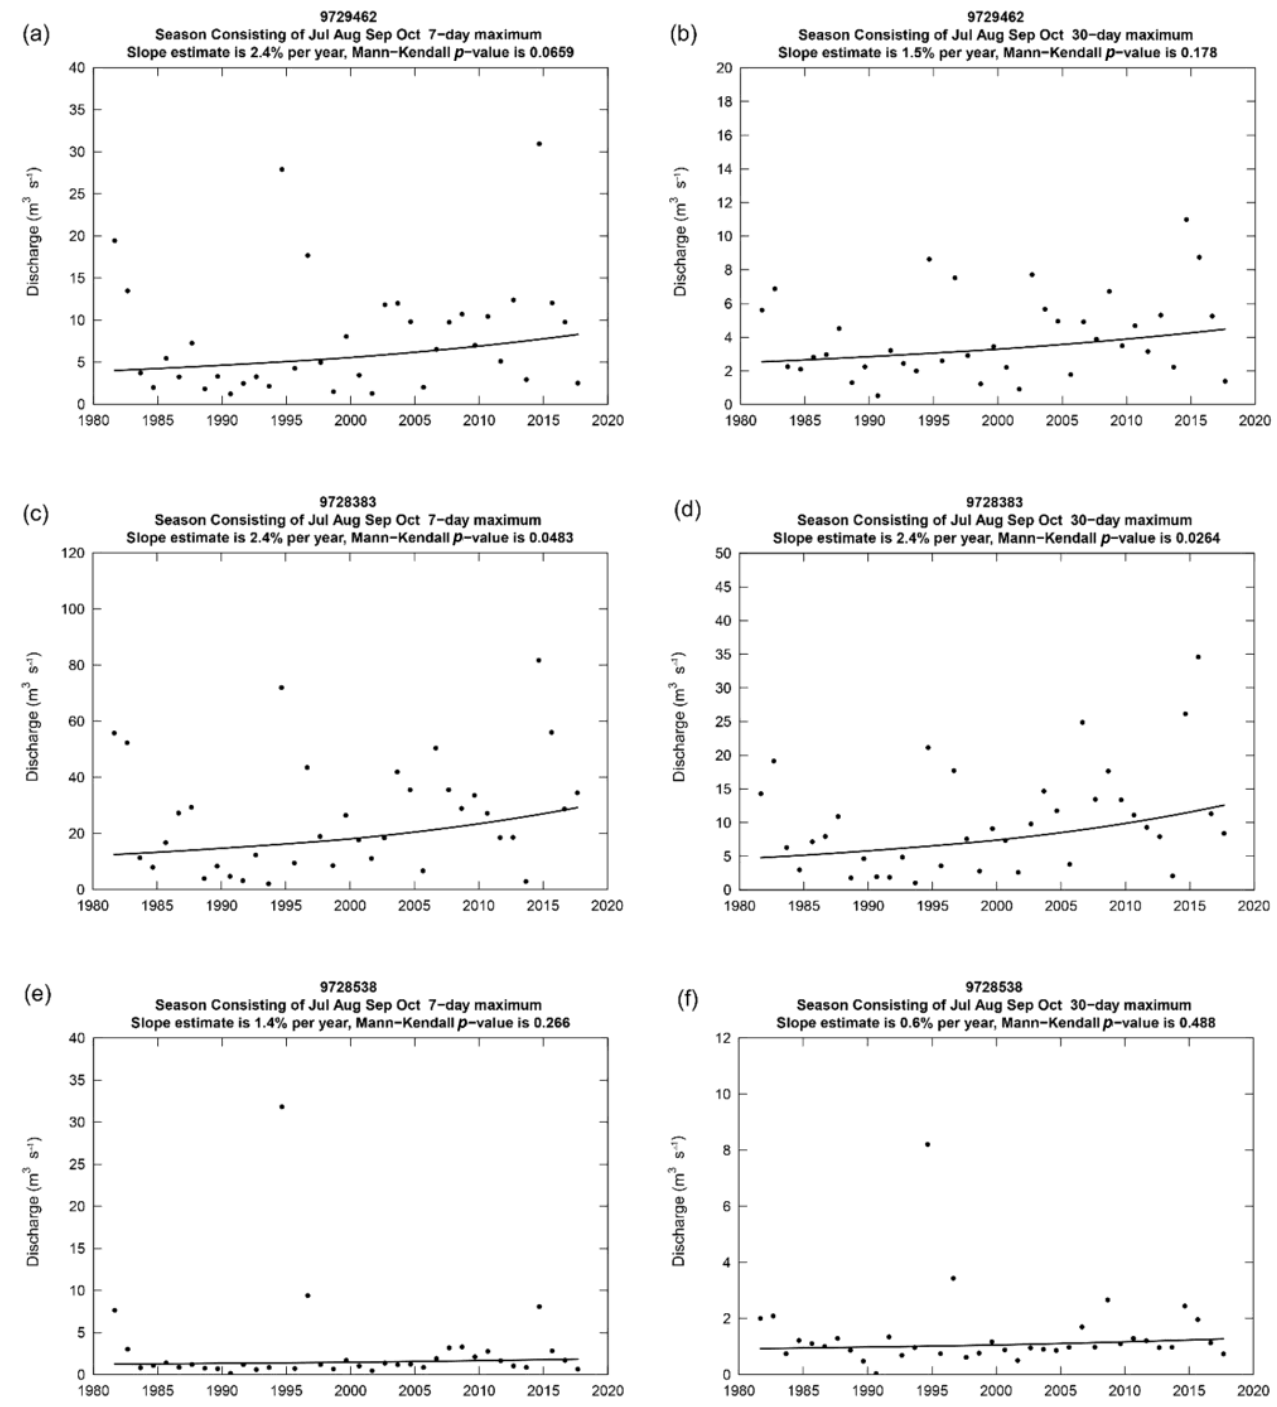
Figure 5. The left column shows trends of maximum 7-day average discharges in the ( a ) PINUP, ( c ) TITAR, and ( e ) MREMA sub-basins, whereas the right column shows trends of maximum 30-day average discharges in the ( b ) PINUP, ( d ) TITAR and ( f ) MREMA sub-basins, respectively, during the period 1981–2017 from July to October. A Thiel-Sen slope and a two-sided p -value for the Mann-Kendall trend test are also presented in the